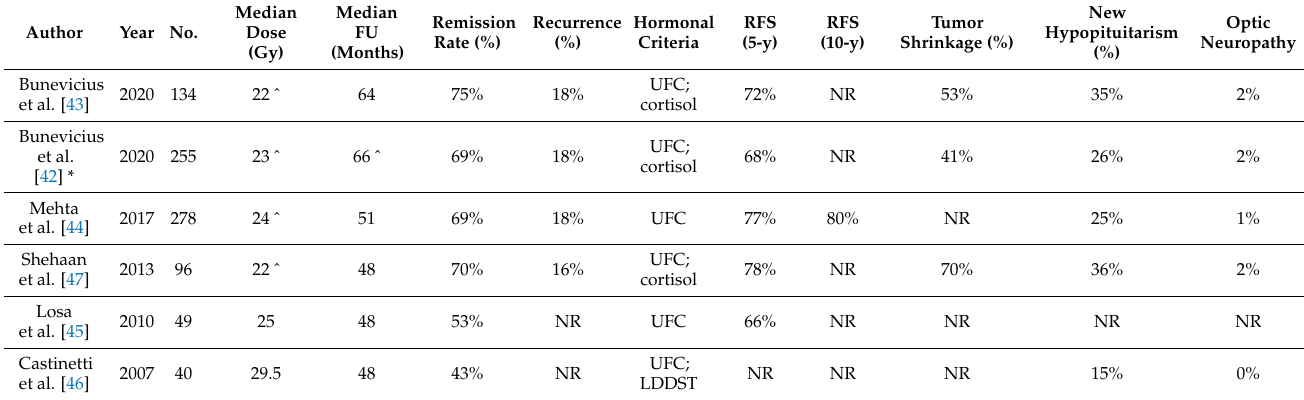
Table 3. ACTH-secreting pituitary adenoma Gamma Knife treatment outcomes and toxicities.